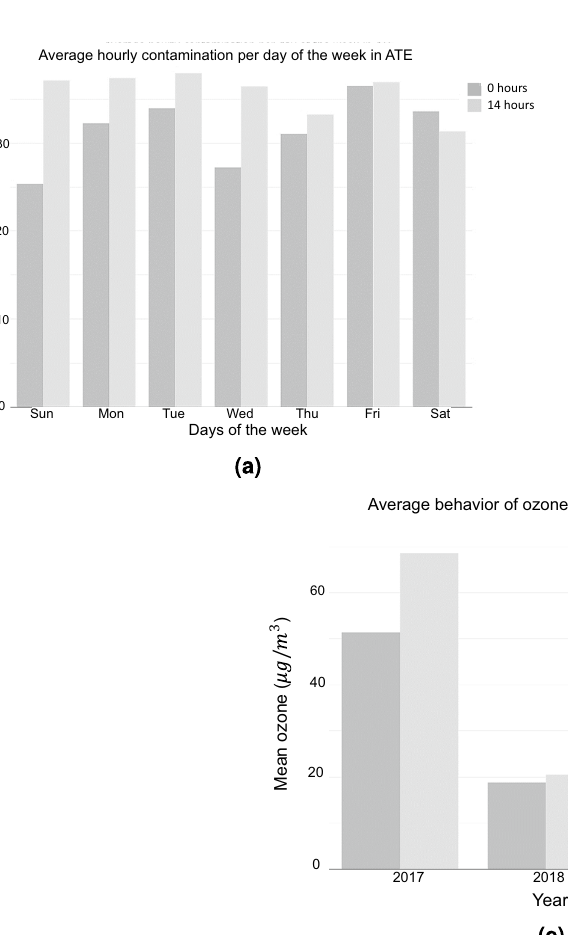
Figure 5. Analysis of average contamination in hourly scale. In this analysis it is observed that the peak hours are 0 h and 14 h. This provides the restriction for the exploratory analysis, reported in Fig. 6.